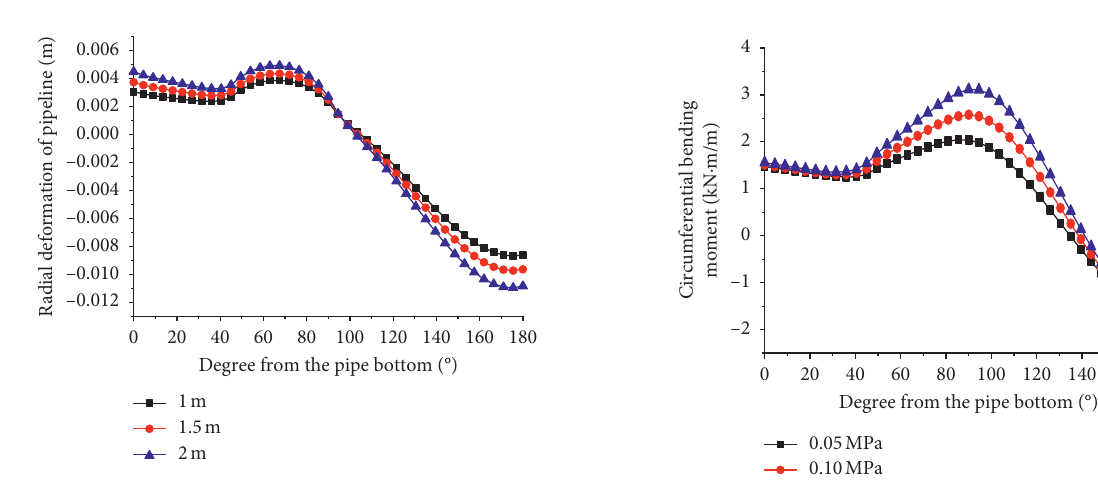
Figure 12: Radial deformation at different buried depths.